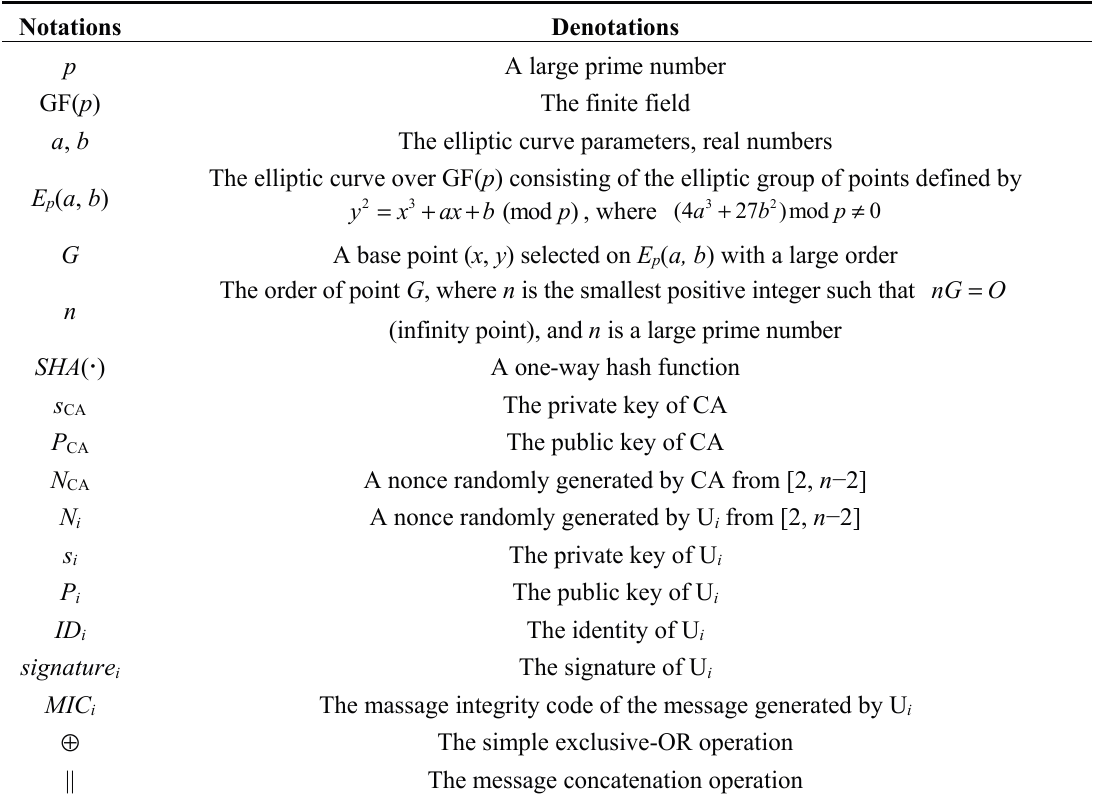
Figure 1. The system architecture of the proposed user authentication scheme in a wireless ad hoc network (WANET). Table 1. Notations and their